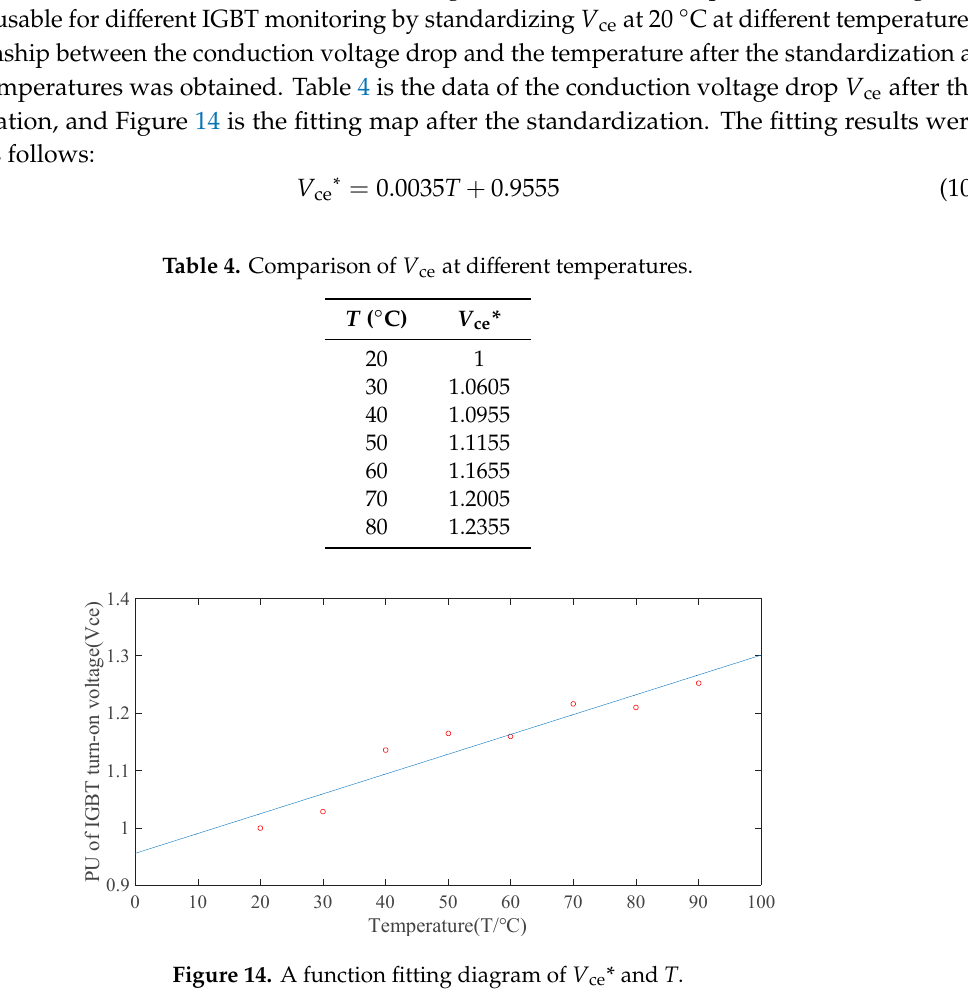
Table 4. Comparison of V ce at di ff erent temperatures.